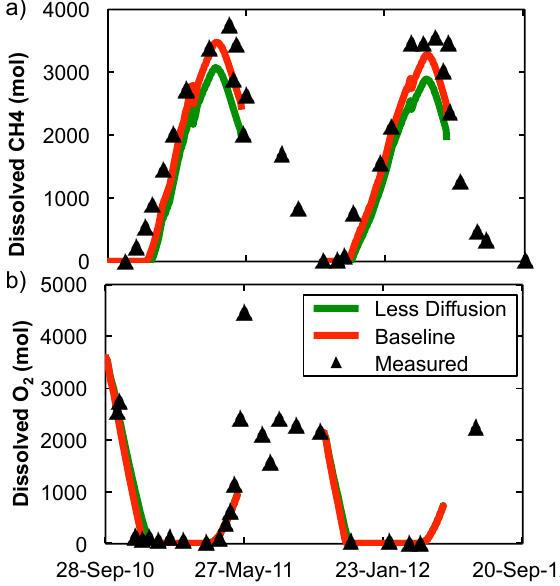
Figure 8. The measured amounts of (a) CH 4 and (b) O 2 dissolved in the water column of Goldstream Lake during the study period, and those calculated in the baseline and “less diffusion” versions of the model (Sect. A1).